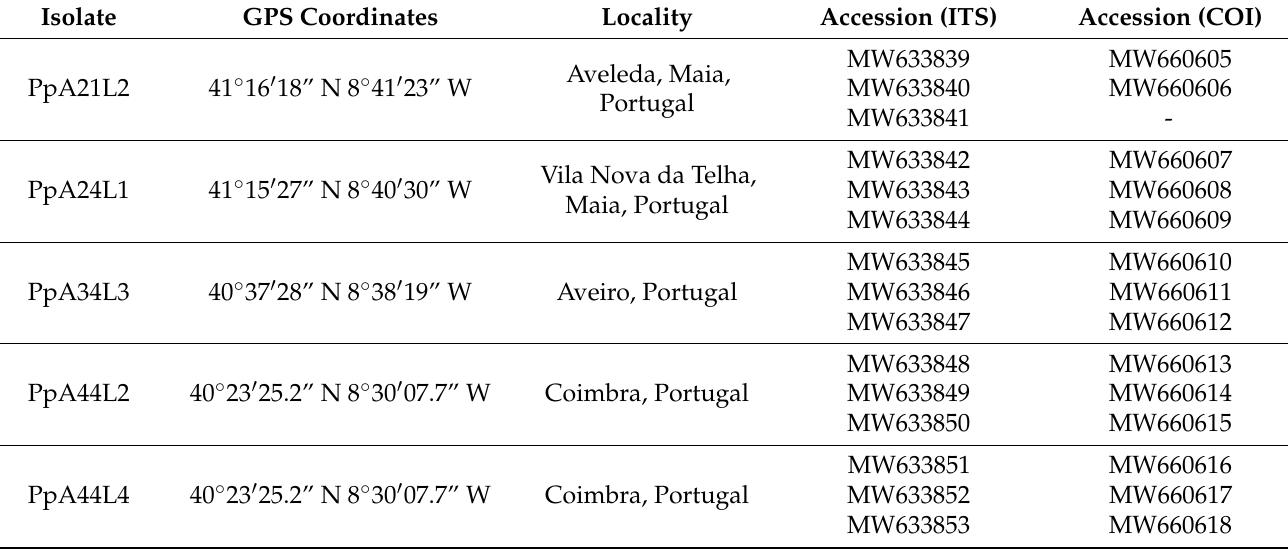
Table 6. Pratylenchus penetrans isolates used in this study, respective geographical origin and GenBank accession numbers. Isolate GPS Coordinates